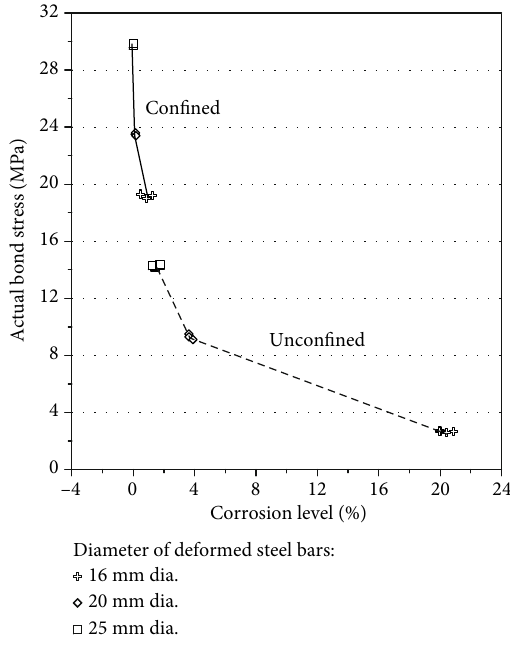
Figure 9: Correlation of bond stress and corrosion level.